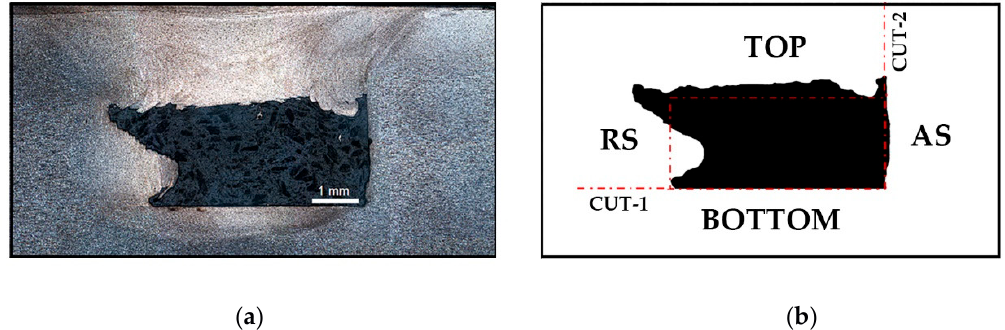
Figure 7. FSC-channel ( a ) macrograph cross-section; ( b ) cross-section sketch with surface names. EDM cut lines shown for the Figure 8.